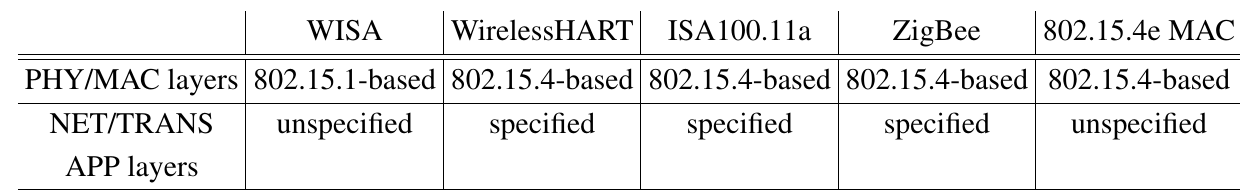
Table 1. Scope of the selected technologies.